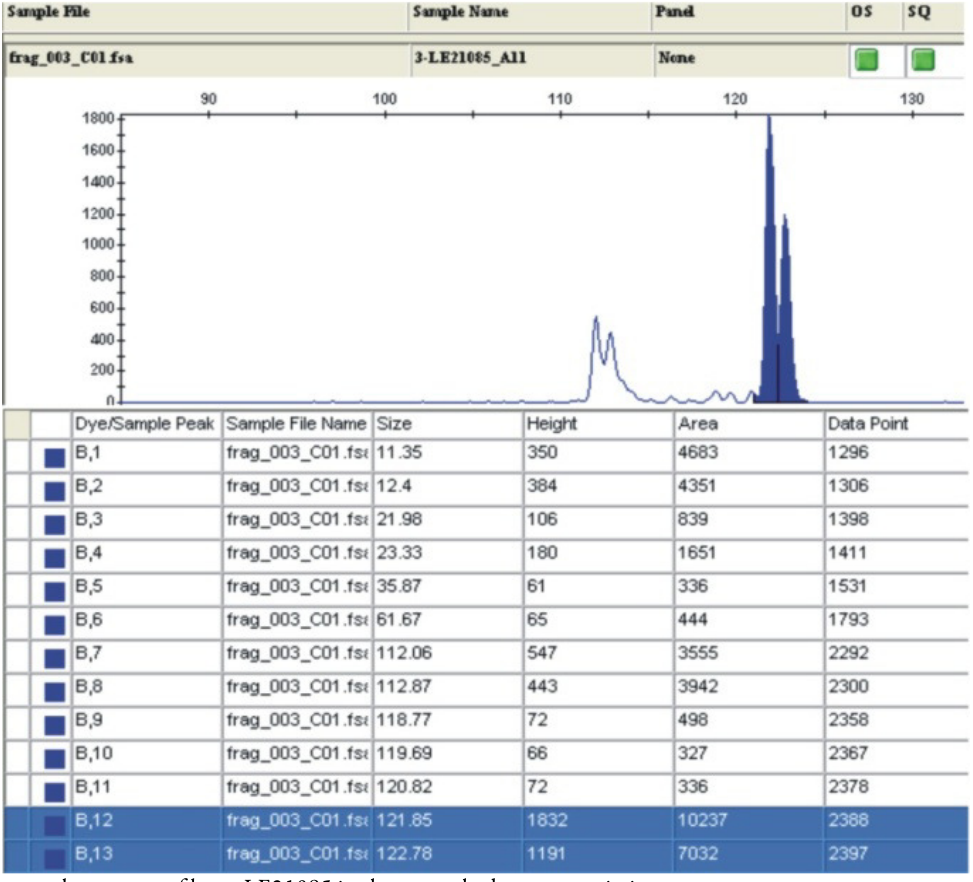
Fig. 1. The electropherograms of locus LE21085 in the researched tomato varieties